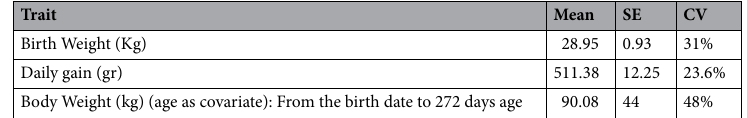
Table 3. The descriptive statistics of body weight traits of dromedary camels.